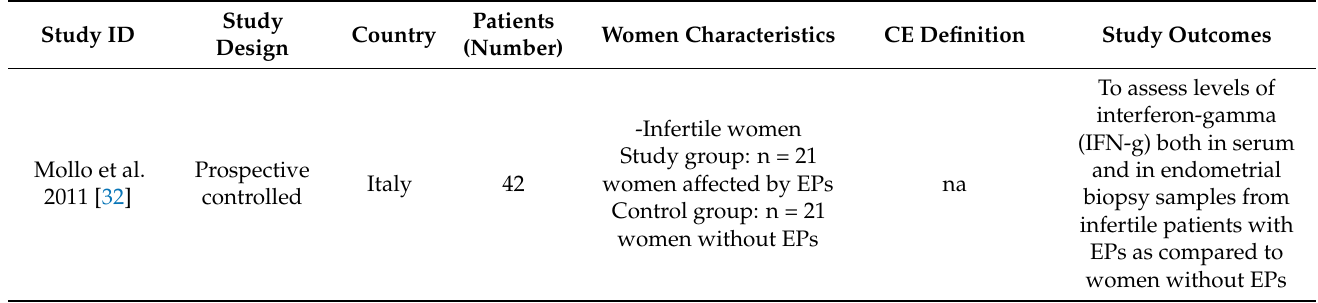
Table A1. General features of the studies excluded after full text